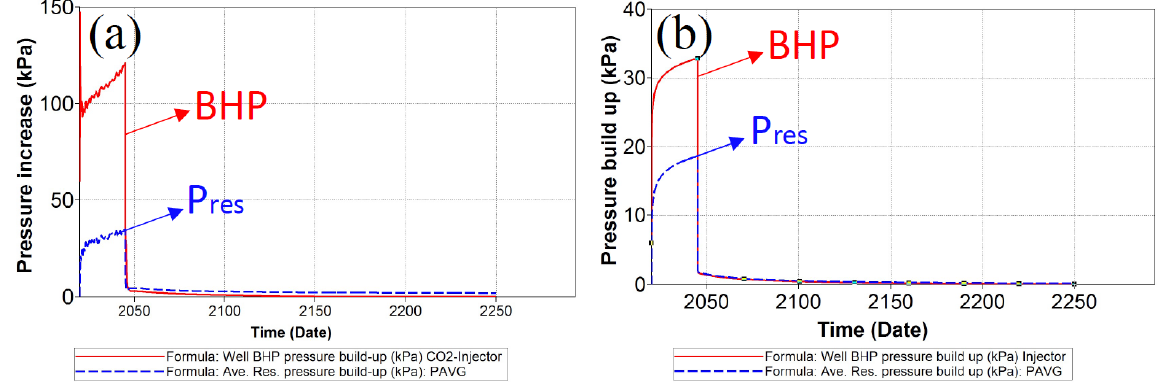
Figure 7. Base case simulation showing the pressure buildup in the bottomhole and the reservoir for ( a ) CO 2 injection and ( b ) low-salinity water injection.